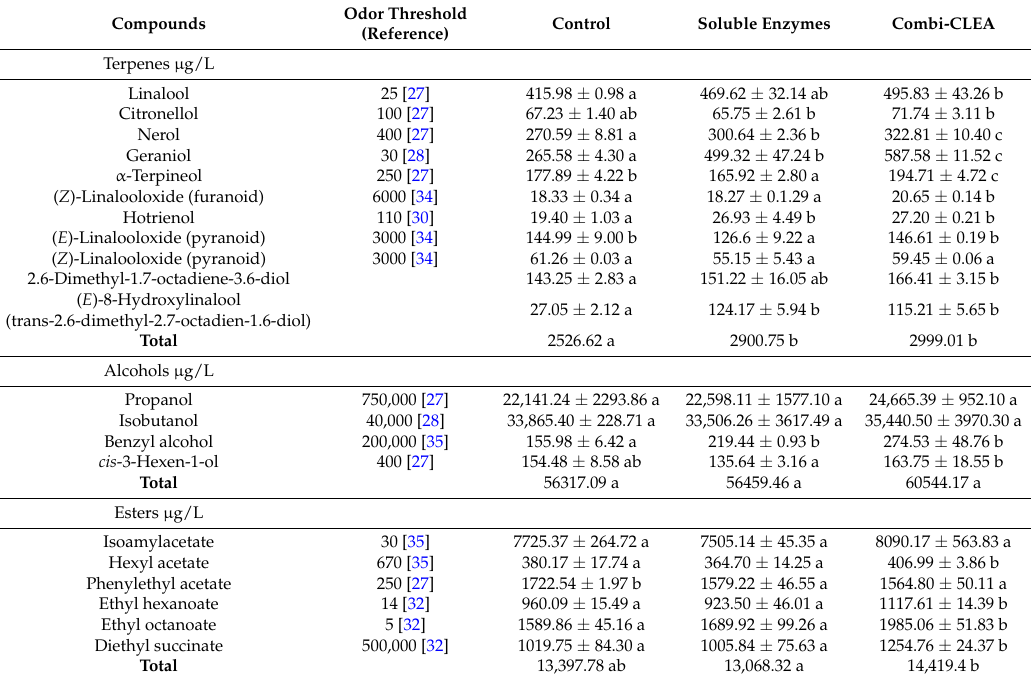
Table 2. Volatile compounds content in Muscat control wines and Muscat wines treated with soluble enzymes and